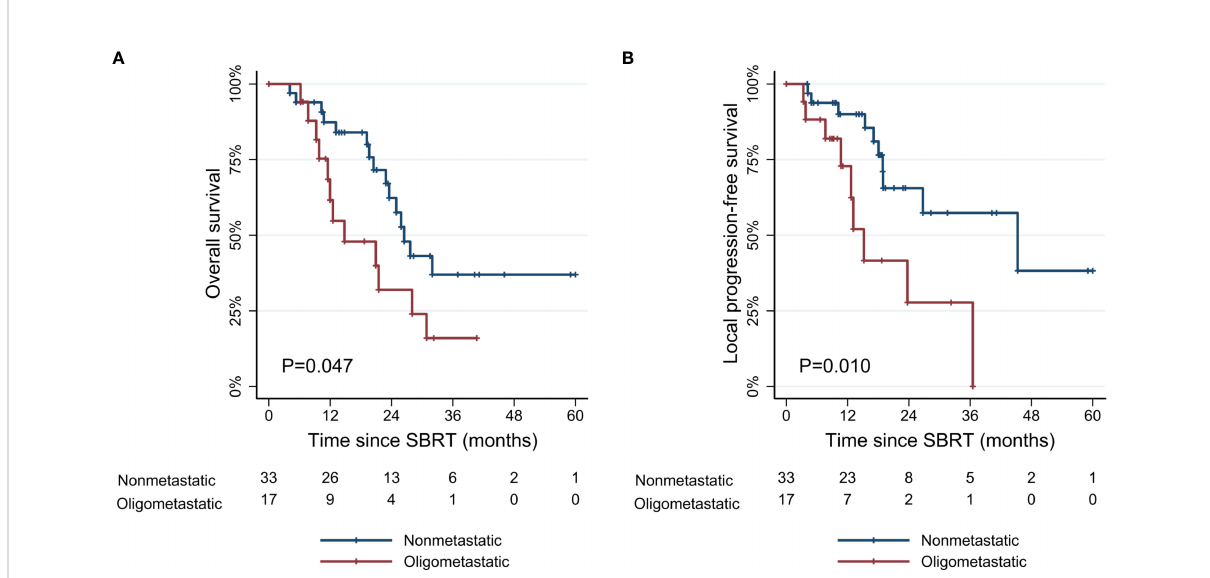
FIGURE 3 Kaplan-Meier curves of (A) overall survival, and (B) local progression-free survival according to metastatic status. SBRT, stereotactic body